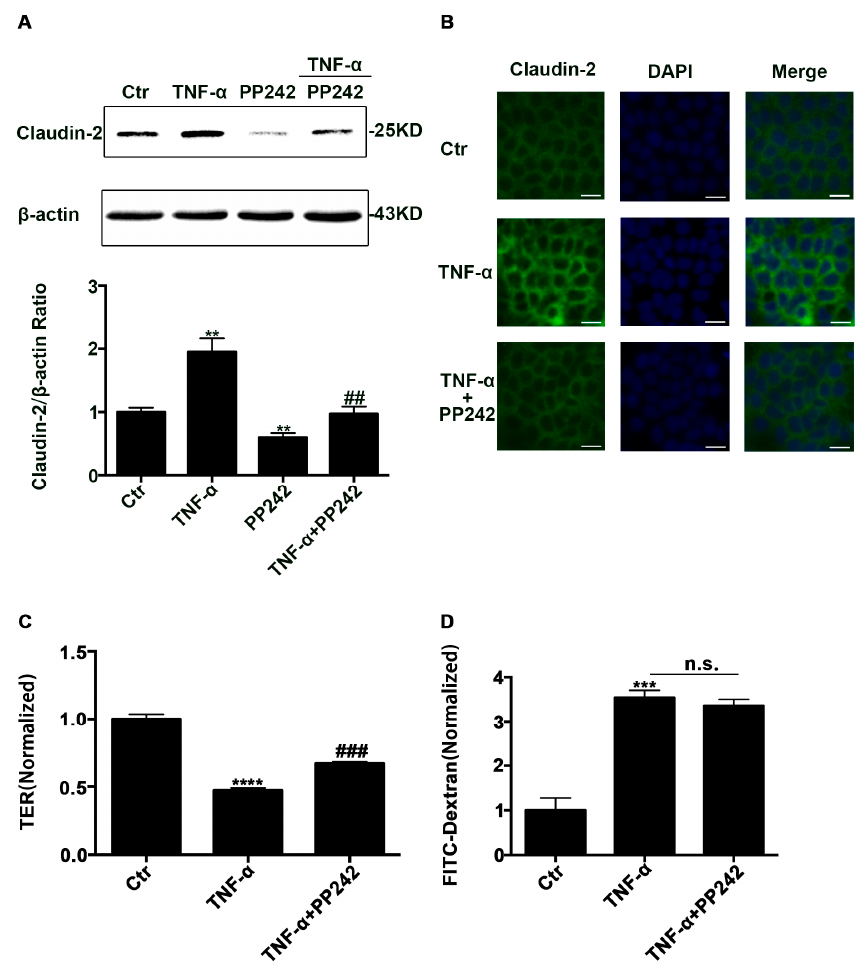
Figure 5. PP242 alleviated the change of claudin-2 expression and intestinal epithelial tight junction function in TNF- α treated Caco-2 cells. ( A ) Western blot analysis of claudin-2 after TNF- α (10 ng/mL, 48 h) and/or PP242 (1 μ m, 24 h) treatment. ( B ) Immunofluorescence staining of claudin-2 after TNF- α and/or PP242 treatment in Caco-2 cell monolayers. The green and blue fluorescence were represented the claudin-2 protein and nucleus, respectively. Scale bar: 20 μ m. ( C ) The effect of PP242 (1 μ m, 24 h) on TER of Caco-2 cell monolayers treated with TNF- α (10 ng/mL, 48 h). ( D ) The effect of PP242 on the permeability of FITC-dextran in TNF- α treated Caco-2 cell monolayers. Data were shown as mean ± SD and replicated three times. ** p < 0.01, *** p < 0.001, **** p < 0.0001 versus control group. ## p < 0.01, ### p < 0.001 versus TNF- α group. n.s., no significant. Ctr, control group. 2.6. Repeated Experiments in IEC-6 Cells Confirmed PP242 Alleviated the Change of Lysosome pH, Autophagic Flux, Claudin-2 Protein, and Intestinal Epithelial Tight Junction Function Induced by TNF- α